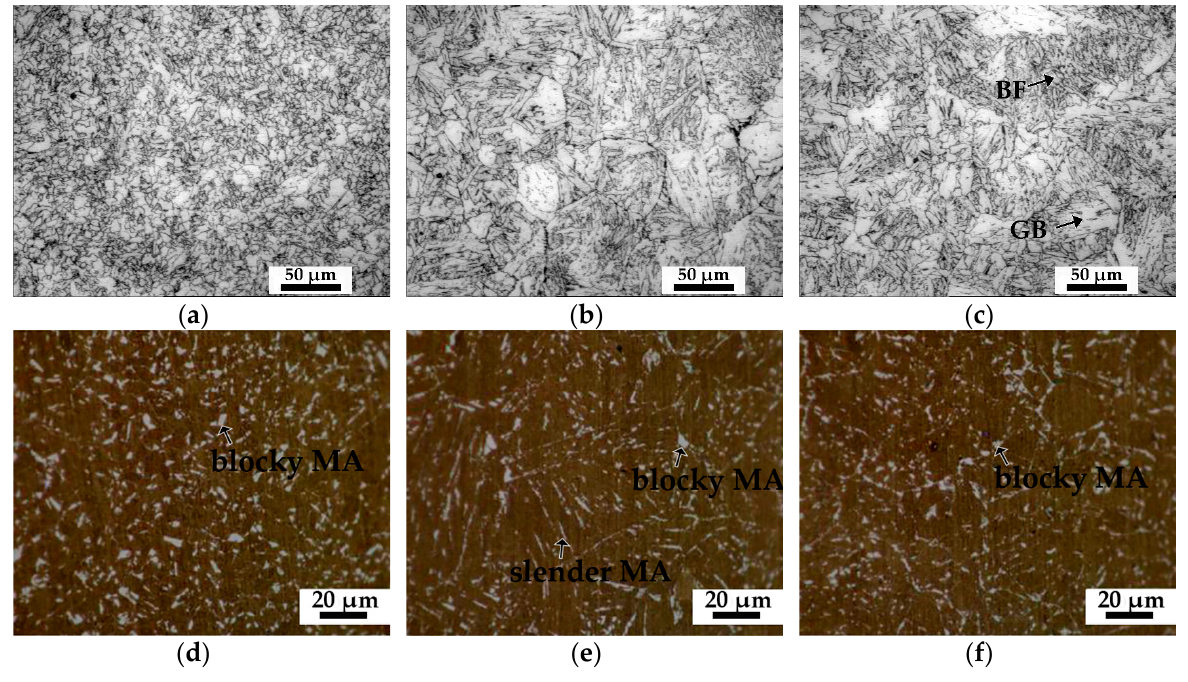
Figure 6. OM images showing the microstructure and MA constituents of the reheated CGHAZ. ( a , d ) SC CGHAZ; ( b , e ) IC CGHAZ; ( c , f ) S CGHAZ.